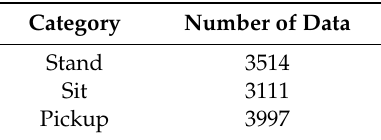
Table 2. Behavior in datasets.